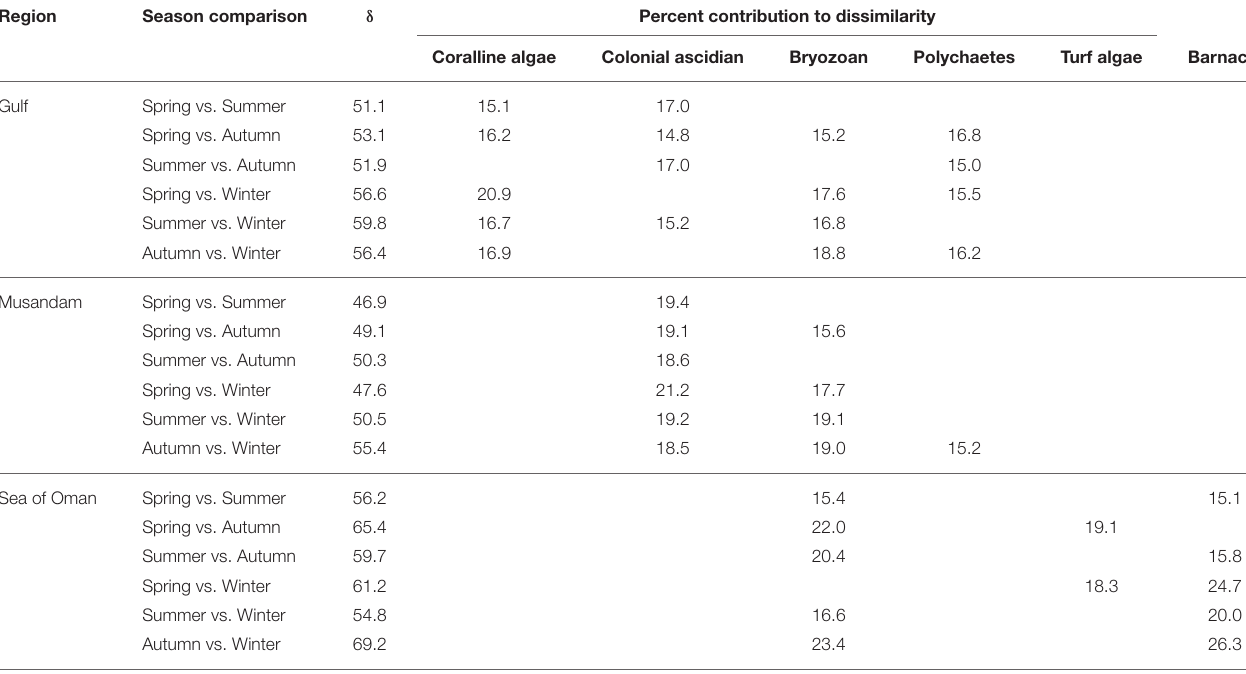
TABLE 3 | Benthic taxa identified as important seasonal drivers of divergence in community structure in SIMPER.